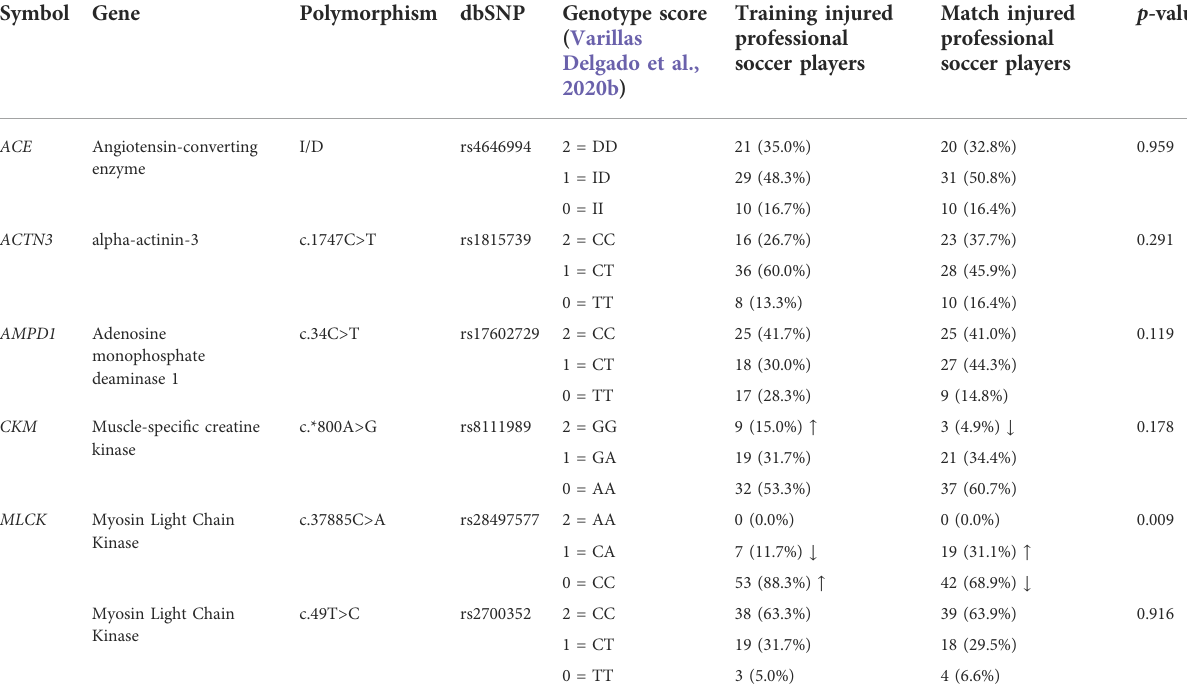
TABLE 7 Genotype distribution in professional soccer players with matches and training injuries for muscle injuries polygenic pro fi le. Symbol Gene Polymorphism dbSNP Genotype score